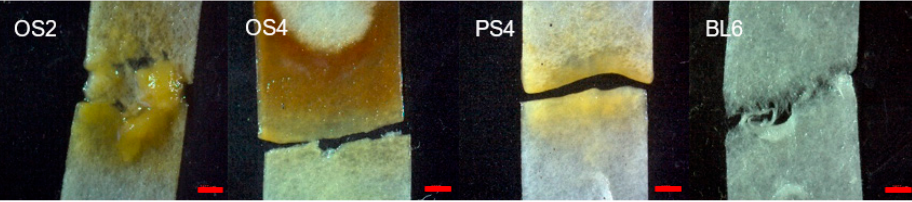
Figure 1. Maceration of the filter paper by each microbial consortium. OS2—oat straw, 2-month composting period; OS4—oat straw, 4 month; PS4—pine sawdust, 4 month; BL6—birch leaf litter, 6 month. The red scale bar is 2 mm. Table 1. Characteristics of isolated microbial consortia.